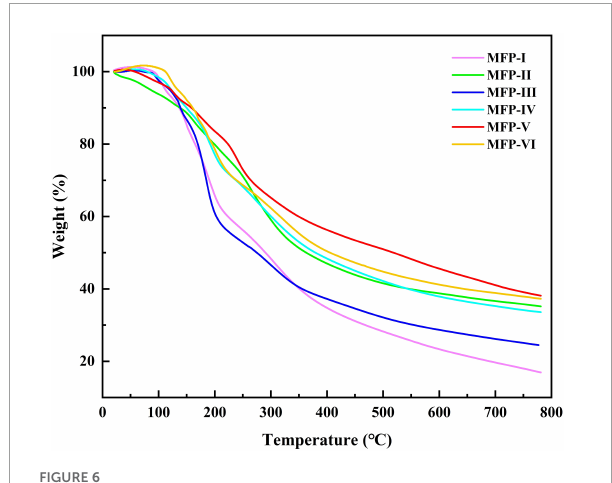
FIGURE6 TG curves of mulberry polysaccharide samples prepared by different extraction